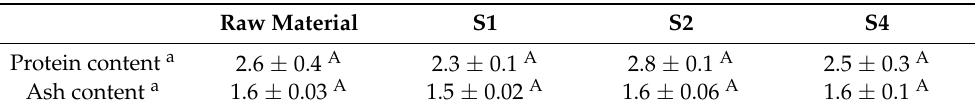
Table A1. Protein and ash contents (g/100 g dm, mean value ± standard deviation, n = 3) of extruded enzymatically treated apple pomace (raw and extruded). S1: only transport elements, S2: two reverse elements, S4: two reverse elements and a kneading block.